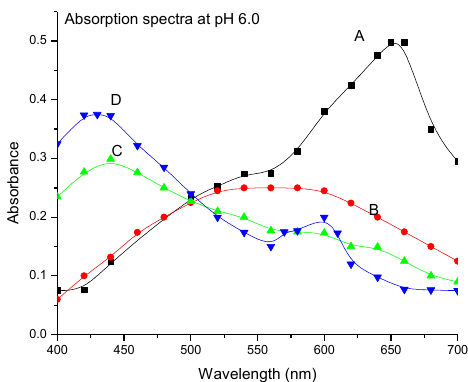
Figure 7. Absorption spectra of Yb at pH 6.0, A- ECAB-CDMEAB- Yb-(Ternary complex). B- ECAB-Yb at (pH 6.0)-(Binary complex), C -ECAB-CDMEAB-(Modified reagent), D